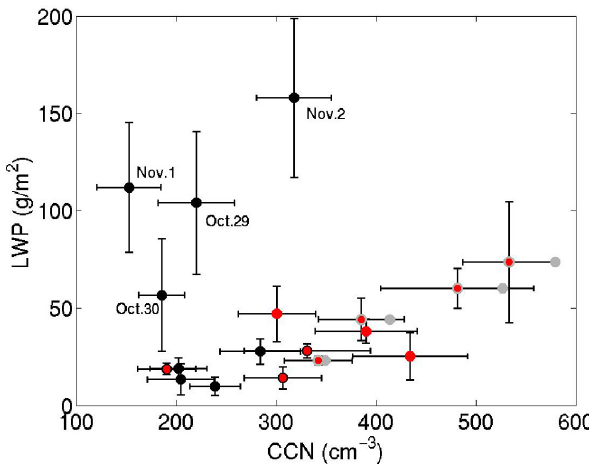
Fig. 15. LWP as a function of subcloud CCN concentrations for all flight days. The horizontal error bars through these symbols indi- cate the standard deviation of CCN. The uncertainty of the LWP denoted as the vertical bars. Red solid symbols are the typical well mixed boundary with non-drizzling Sc discussed in Zheng et al. (2010). The average 0.5% CCN values for the first four flight days are indicated as the gray dots, and the corresponded 0.2% CCN values are marked as the red dots with gray